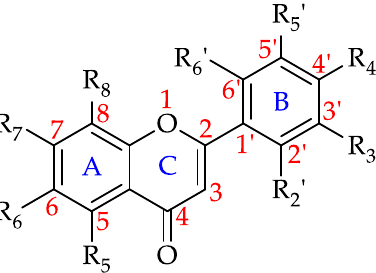
Figure 7. Basic flavone structure (see 1 – 12 in Table 2).